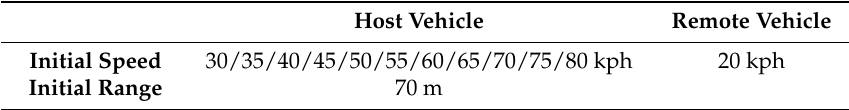
Table 1. Initial setting condition for sensor data acquisition.